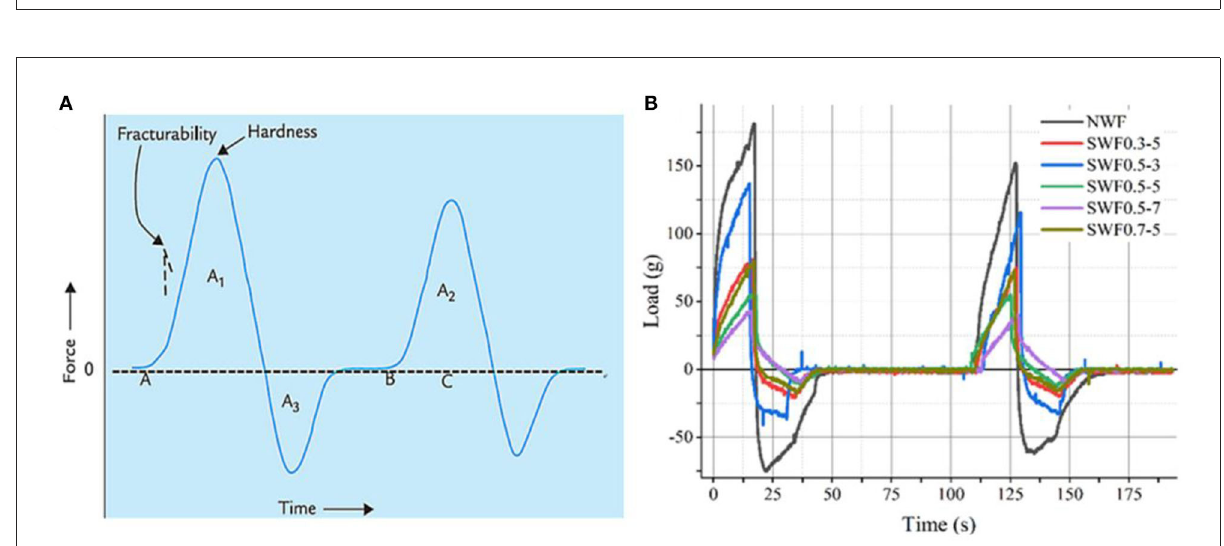
FIGURE5 A typical texturometer curve (A) (cohesiveness = A 2 /A 1 , adhesiveness = A 3 ) (49) and loading image of brown rice pastes (B) . NBR, native brown rice powder; SBR, steam exploded brown rice powder; SBR0.3-5, SBR at 0.3 MPa for 5min, SBR0.5-3, SBR at 0.5 MPa for 3min; SBR0.5-5, SBR at 0.5 MPa for 5min; SBR0.5-7, SBR at 0.5 MPa for 7min; SBR0.7-5, SBR at 0.7 MPa for